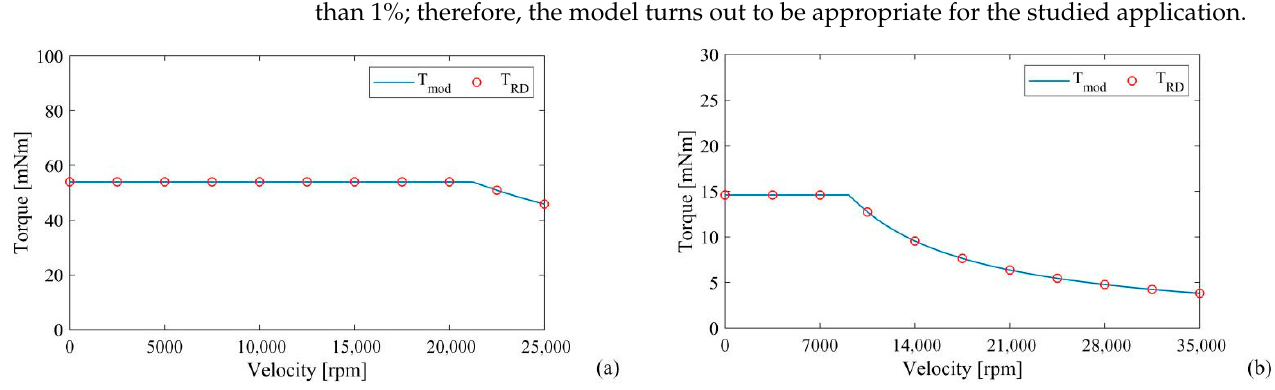
Figure 7. Validation tests of ( a ) the propulsion motor and ( b ) the directional motor.